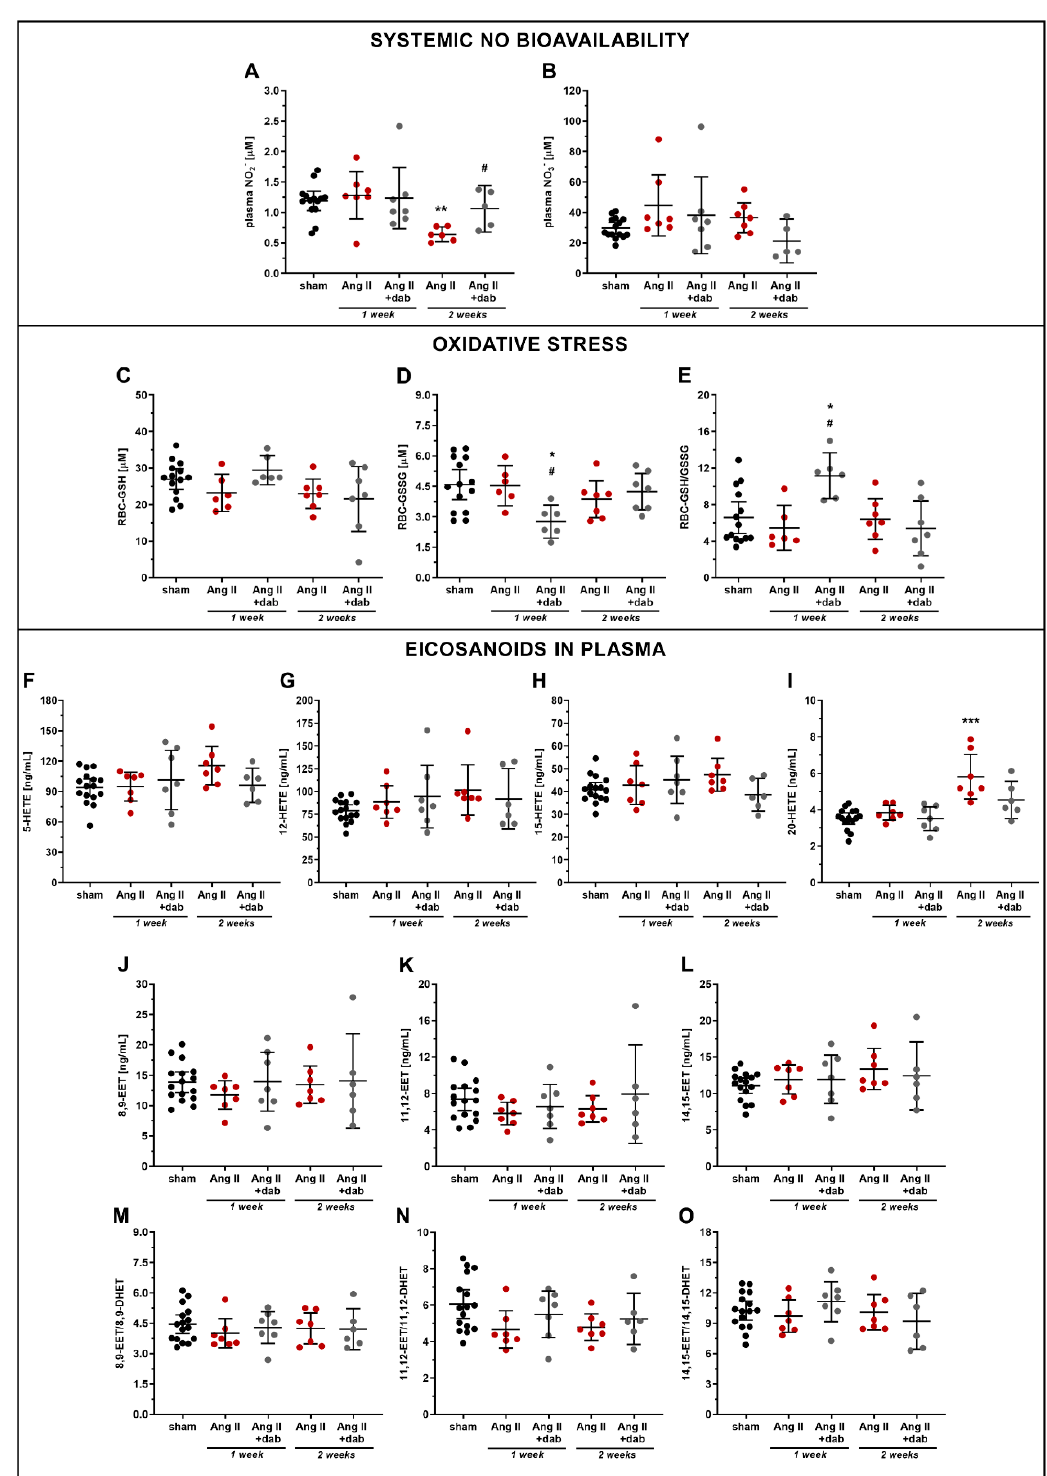
Figure 4. Effect of dabigatran on NO bioavailability, oxidative stress, and plasma eicosanoids in Ang II hypertensive mice. Concentration of plasma NO metabolites ( A , B ; n = 5–15) and oxidative stress markers including reduced glutathione GSH ( C ; n = 6–14), oxidised glutathione GSSG ( D ; n = 6–14), and their ratio ( E ; n = 6–14) measured in murine erythrocytes RBC as well as eicosanoid concentration in plasma ( F – O ; n = 7–14) were evaluated in mice subjected to i.v. continuous infusion of Ang II (144 µg/kg b.w. per day; 2 weeks) via catheters. Data are shown as means (–) ± 95% CI (I) and considered statistically significant at * p ≤ 0.05, ** p ≤ 0.01, and *** p ≤ 0.001, # p ≤ 0.05 using Tukey’s post hoc ( A , E , F , I – K , N , O ) and Kruskal–Wallis ( B – D , G , H , L , M ) statistical tests. * indicates statistical difference between sham mice and Ang II- or Ang II+ dab-treated animals, # indicates statistical difference between Ang II- and Ang II+ dab-treated